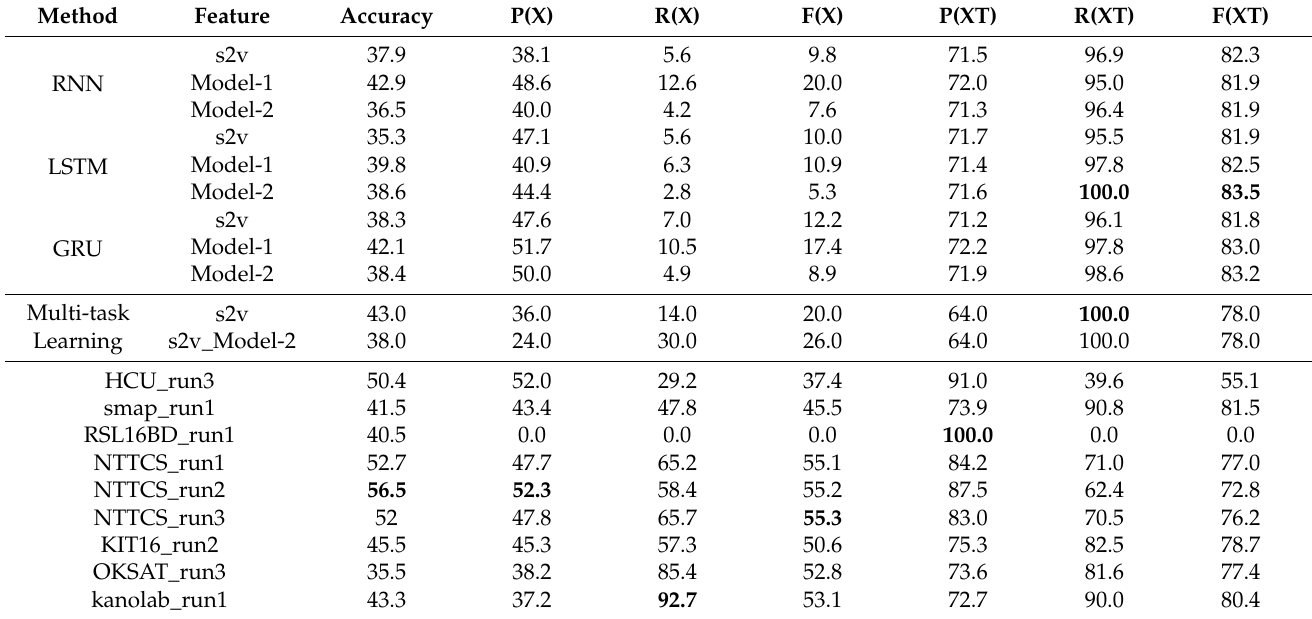
Table 13. Comparison with the other methods presented in DBDC2 (DCM).